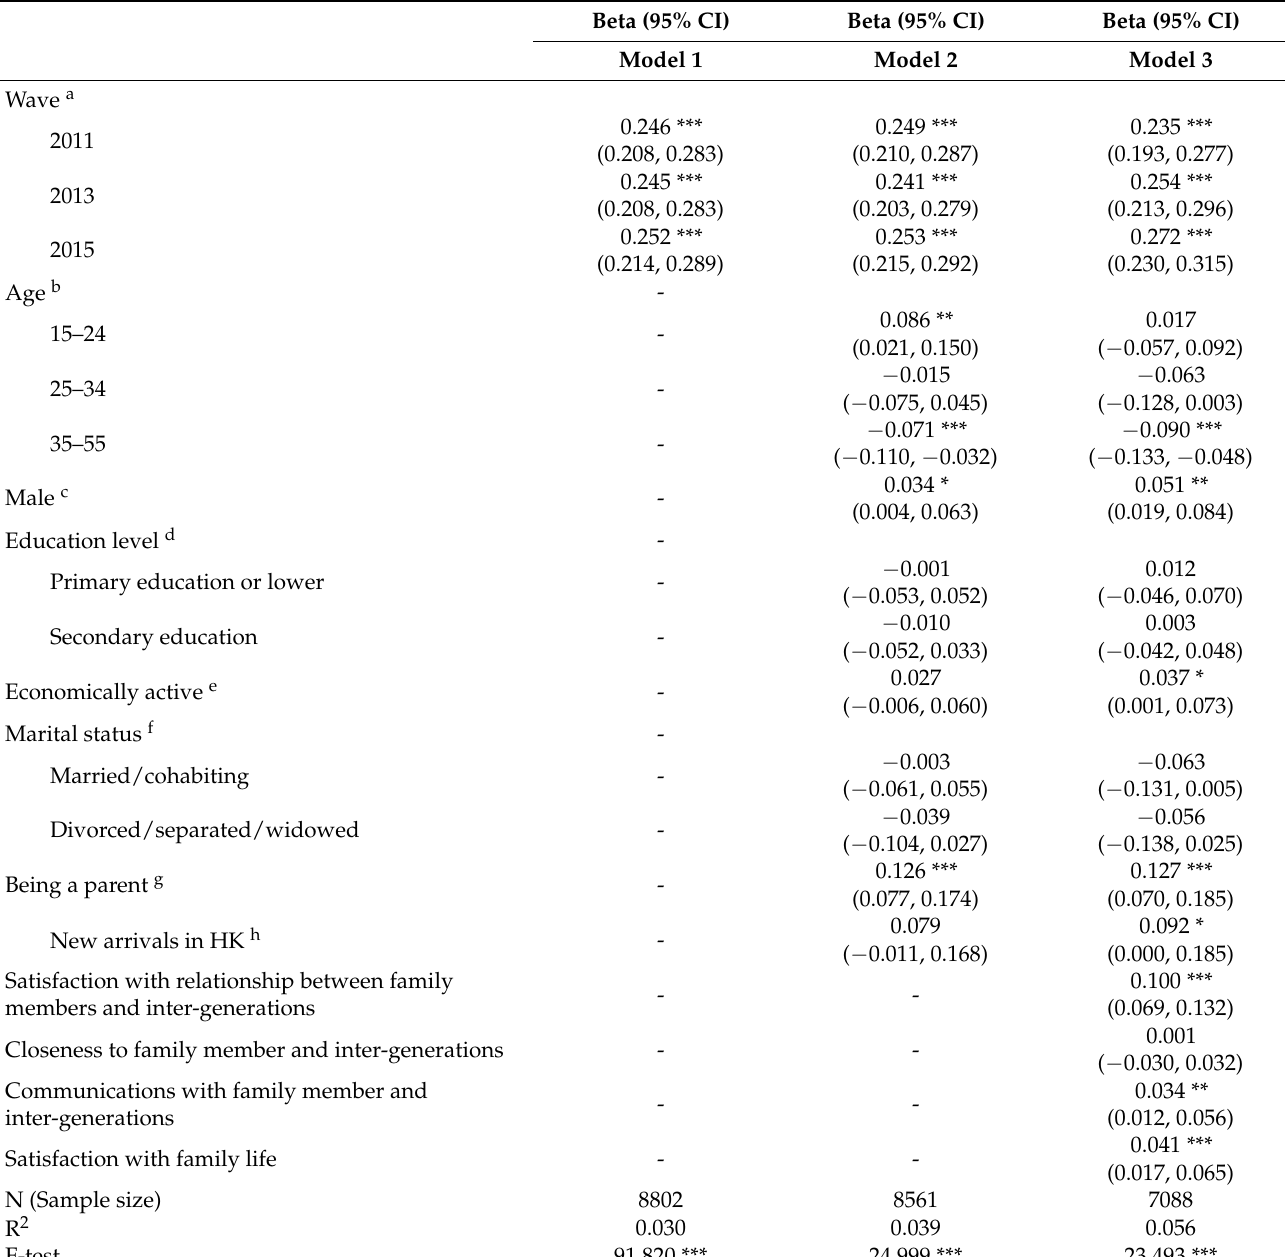
Table 4. Factors Associated with Attitude Toward Grandparental